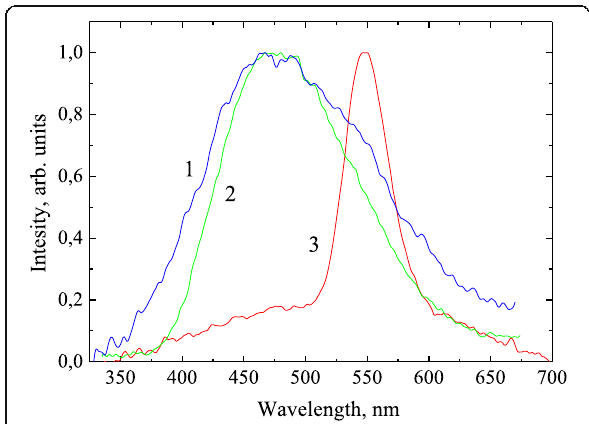
Fig. 4 Normalized luminescence spectra under X-ray excitation: pristine alumina (spectrum 1), phenyl-alumina (spectrum 2), and phenyl-alumina after annealing at 400 °C (spectrum 3) at temperature 90